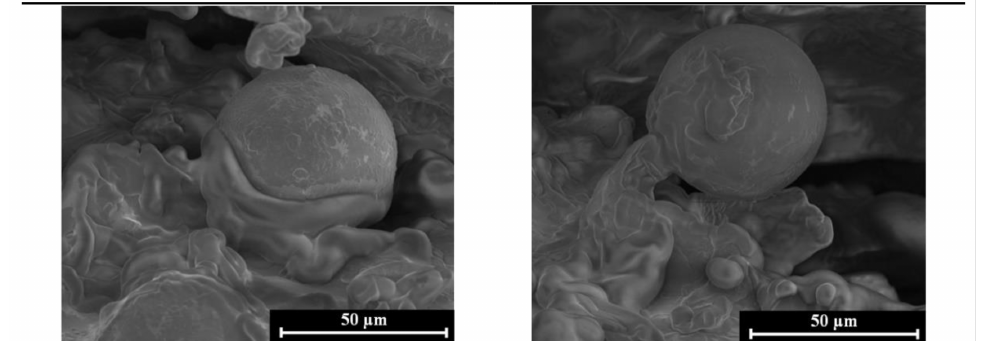
Figure 3. Polylactide (PLA) microparticles incorporated into porous matrix containing sodium